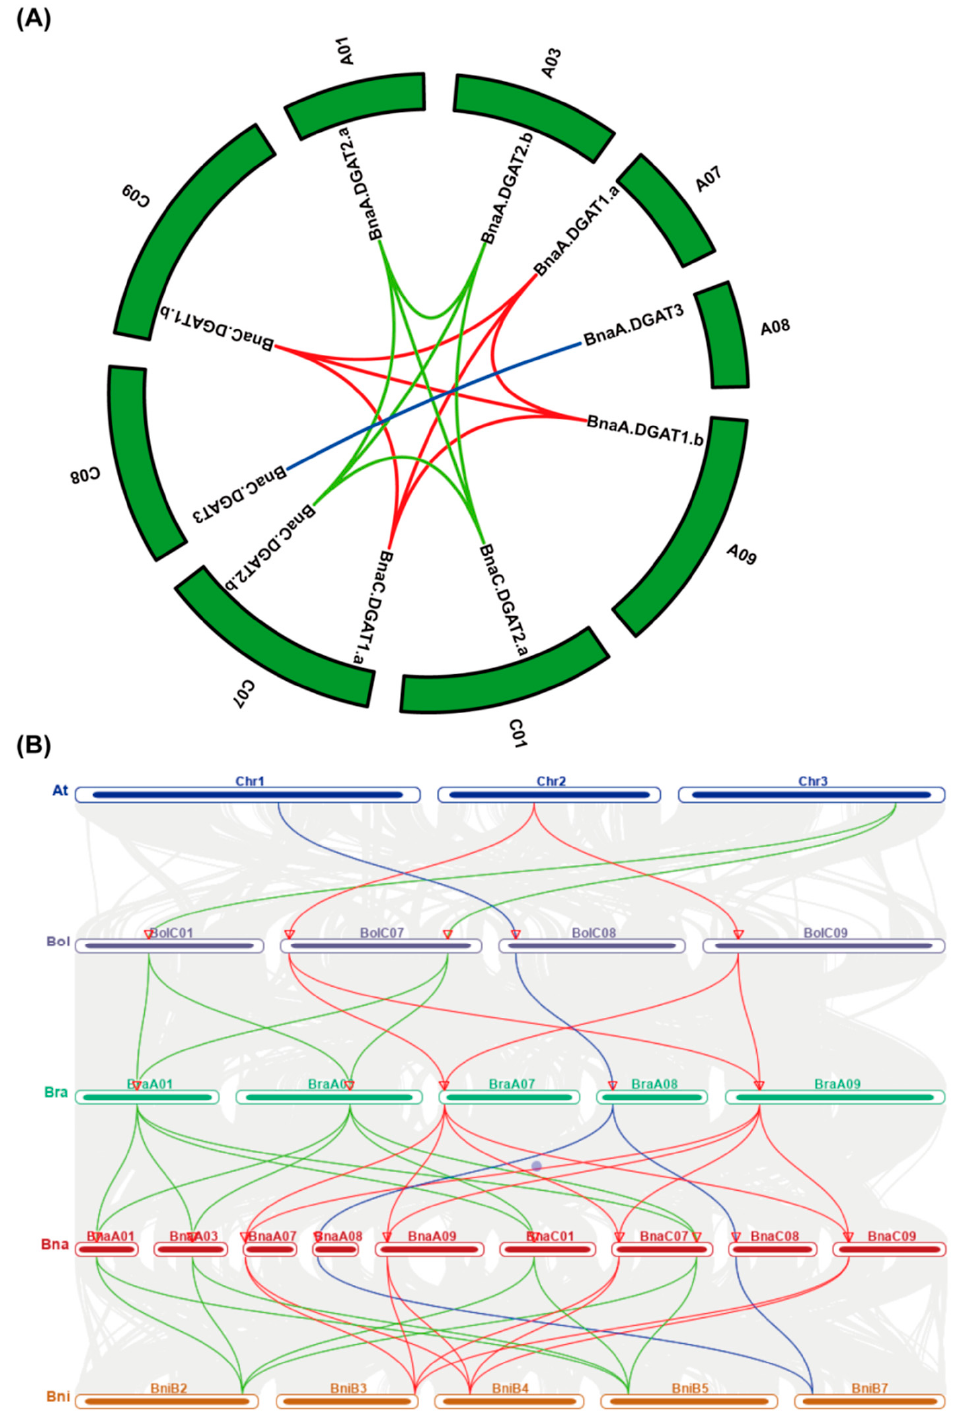
Figure 1. Synteny analysis of DGATs in Arabidopsis thaliana , Brassica oleracea , Brassica rapa , Brassica napus and Brassica nigra . ( A ) Synteny analysis of the BnaDGAT family in B. napus . Red-, green- and blue-colored lines indicate the BnaDGAT1 subfamily, BnaDGAT2 subfamily and BnaDGAT3 subfamily genes, respectively; ( B ) Synteny analysis of DGATs between A. thaliana , B. oleracea , B. rapa , B. napus and B. nigra . Red, green and blue lines indicate the syntenic DGAT1 , DGAT2 and DGAT3 gene pairs between the denoted species, respectively. In the background, the grey line represents collinear